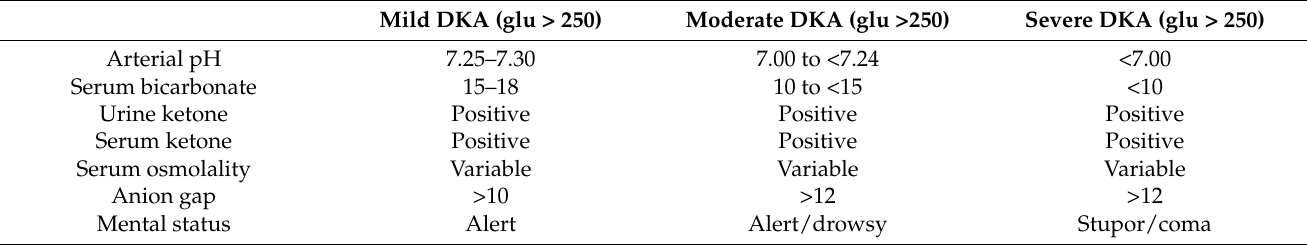
Table 1. Diagnostic criteria and deficits of electrolytes in different stages of diabetic ketoacidosis (DKA). Reprinted/adapted with permission from Kitabchi et al., 2009 “hyperglycemic crises in adult patients with diabetes” [1]. Copyright © 2009 by the American Diabetes Association.